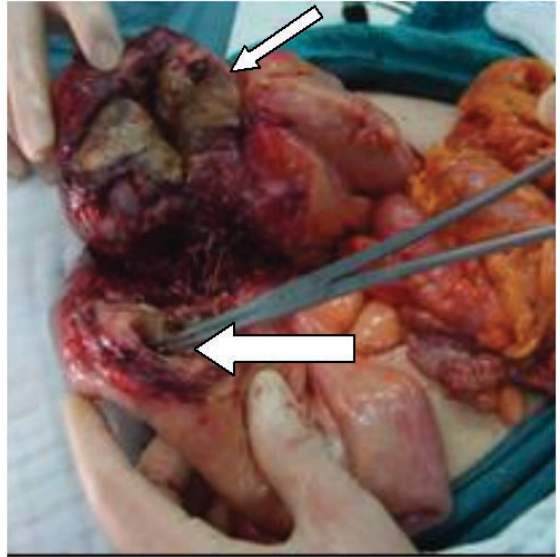
Figure 2. Intraabdominal mass (thin arrow), perforated small bowel (thick